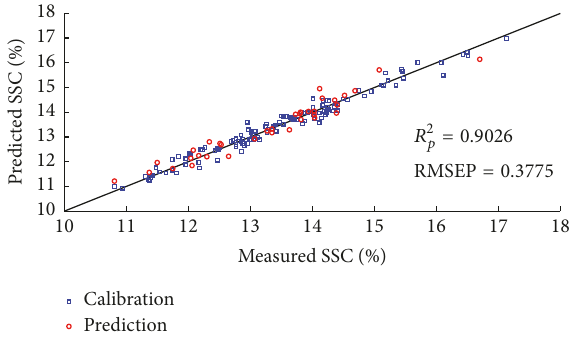
Figure 11: Scatter plots of measured versus predicted values for SSC obtained by the RF-PLS calibration